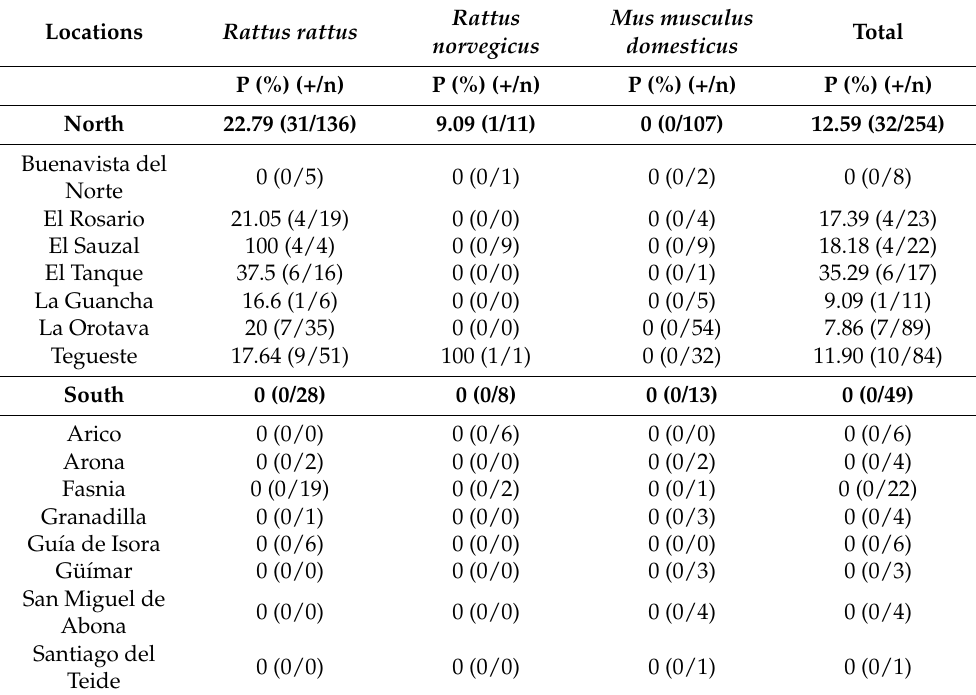
Figure 3. Heat map of the prevalence of Angiostrongylus cantonensis in the island of Tenerife, using the Inverse Distance Weighting (IDW) interpolation method integrated in the interpolation complement of the Quantum GIS software (QGIS). Table 1. Prevalence of Angiostrongylus cantonensis in the island of Tenerife, divided by rodent species as well as location.